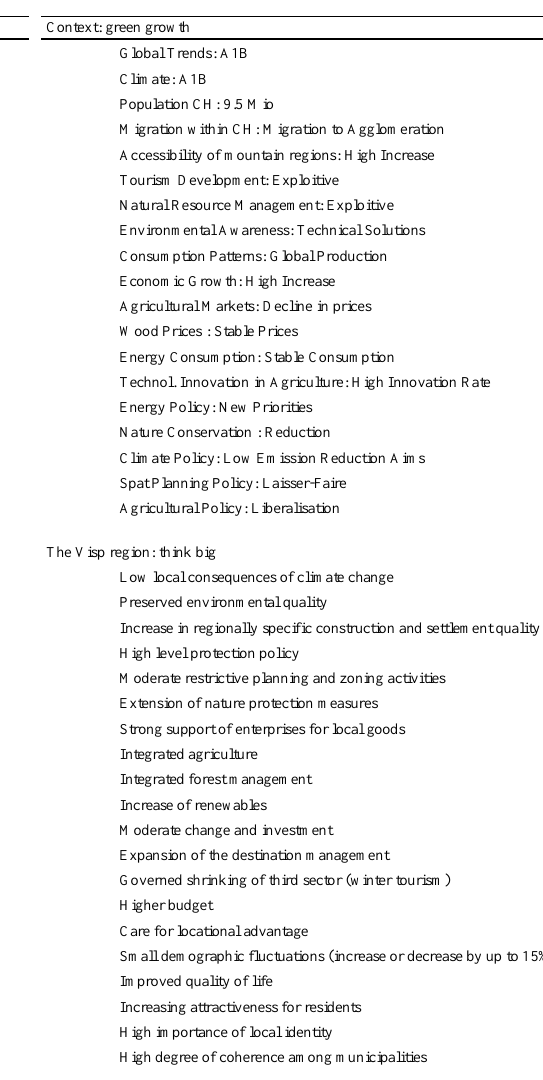
Table 3. Multiscale scenario “clumping risks in a neoliberal world” combining future states of growth and convergence (context) and clumping risks (the Visp region). Context: growth and convergence Context: green